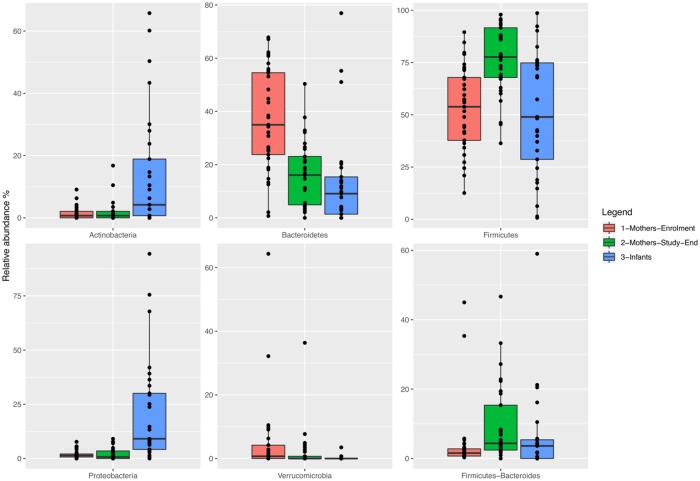
Phylum-level abundance profiles.Boxplots describe the relative abundance of phyla in GDM patients at enrolment (red bars), in GDM patients at the study end (green bars) and in the infants (blue bars).